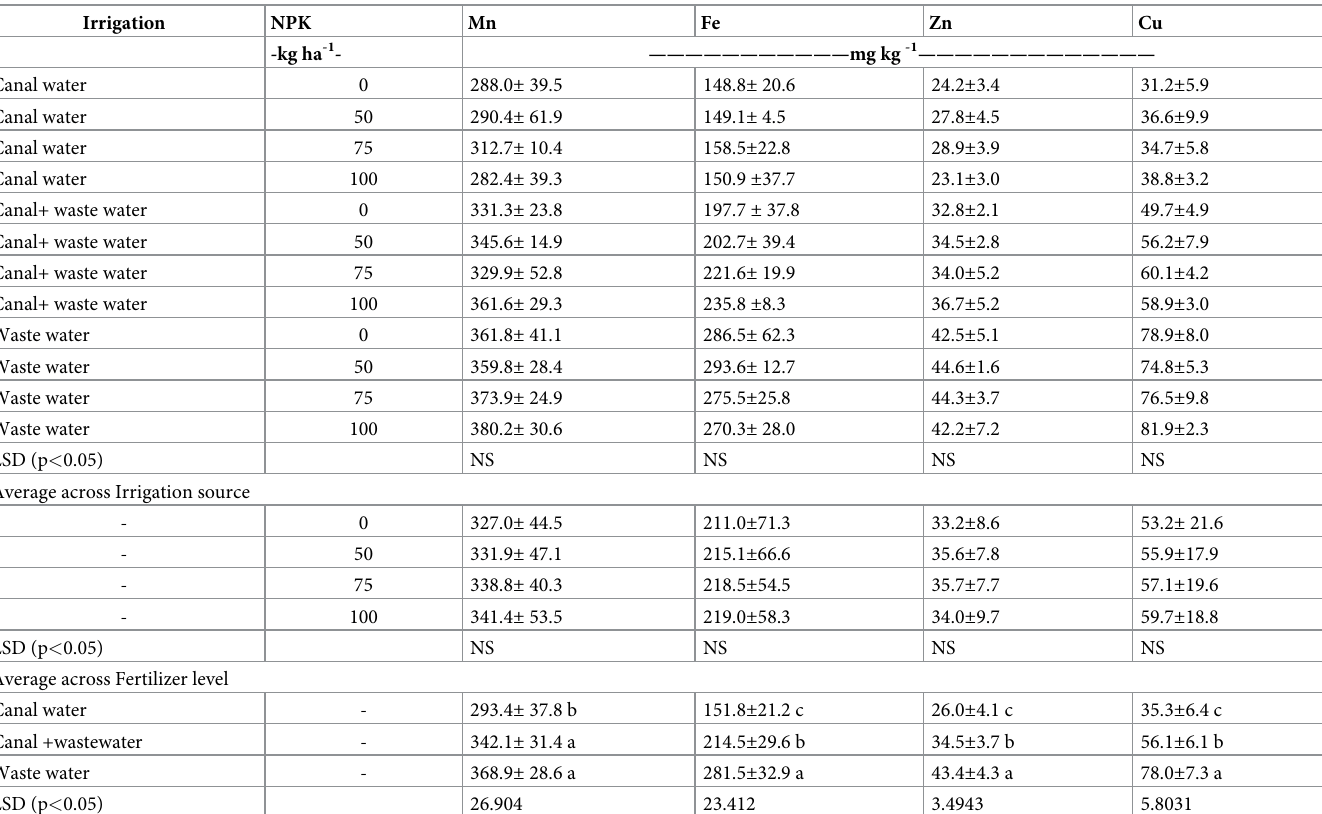
Table 7. Grain heavy metals (mg kg 1 ) as affected by different NPK level and irrigation source.